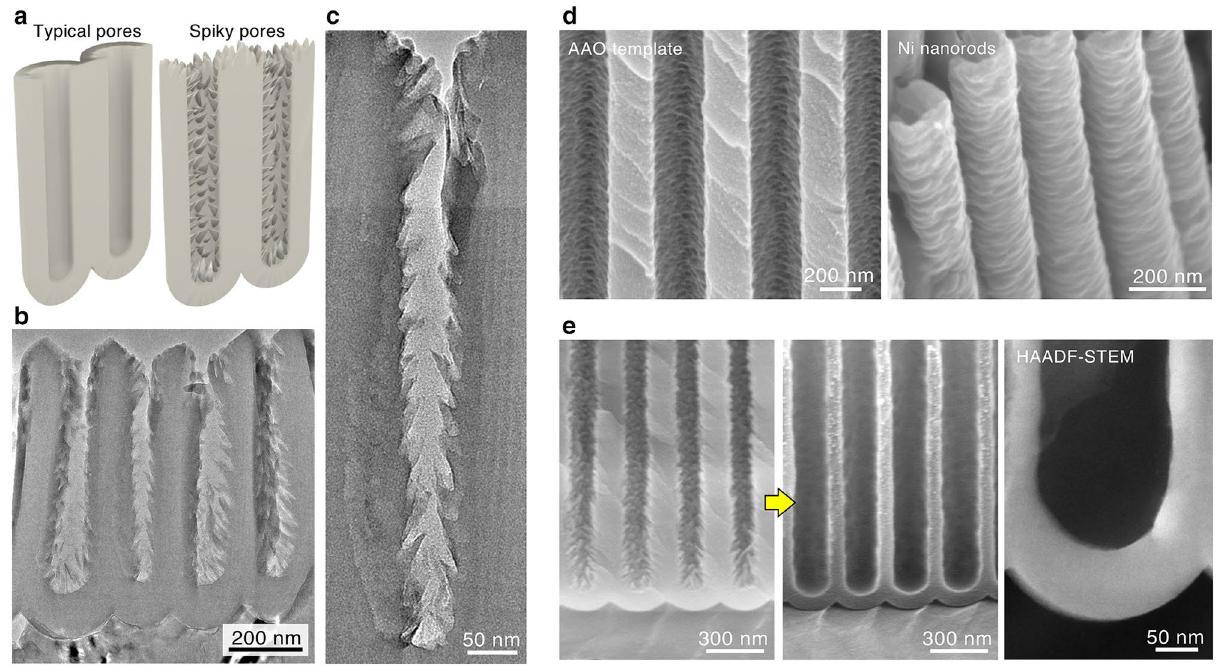
Figure 4. Highly ordered nanospike pore arrays. ( a ) Schematics of the typical porous AAO structure with flat, smooth cylindrical pores formed in typical acidic electrolytes and the nanospike AAO structure with numerous oxide spikes on the pore walls. ( b ) A TEM image of an ordered porous AAO structure fabricated via two- step anodizing of Al in a 0.5 M sodium tetraborate solution at 355 K and 140 V for 120 min (first anodizing process) and 10 min (second anodizing process). ( c ) A high-magnification TEM image of a nanospike pore wall from the top surface to the bottom interface of the porous layer. ( d ) SEM images of the ordered porous AAO template and corresponding Ni nanorods obtained by electroplating using the AAO template with the nanospike morphology. ( e ) Pore-widening of the porous AAO structure in a 1.0 M phosphoric acid solution at 298 K for 120 min. The nanospikes completely disappeared through pore